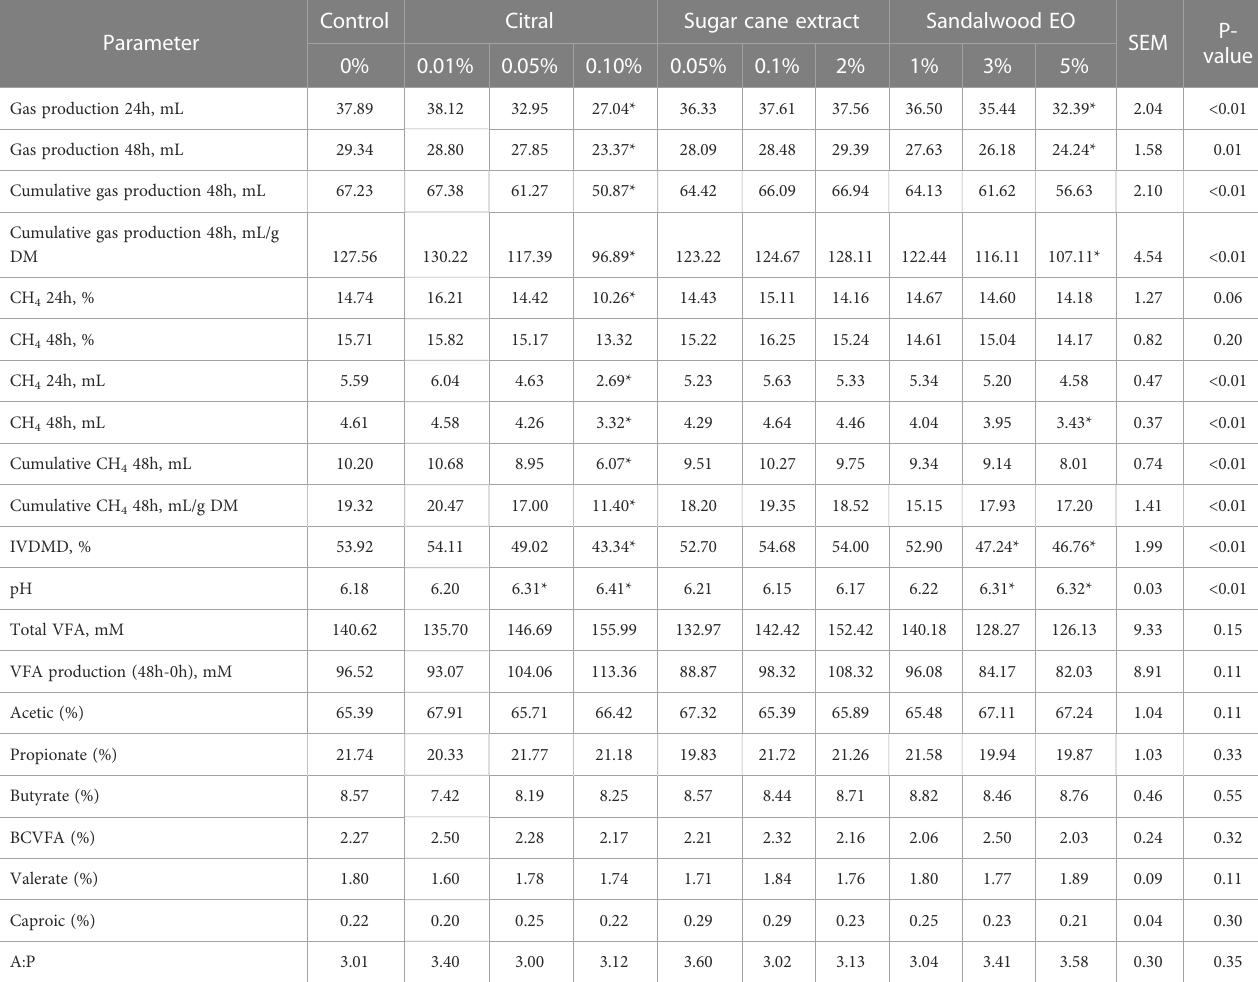
TABLE 3 Effects of liquid additives (% media volume) on rumen fermentation parameters, IVDMD and methane over 24 and 48 h of incubation, through three in vitro batch culture fermentation runs.